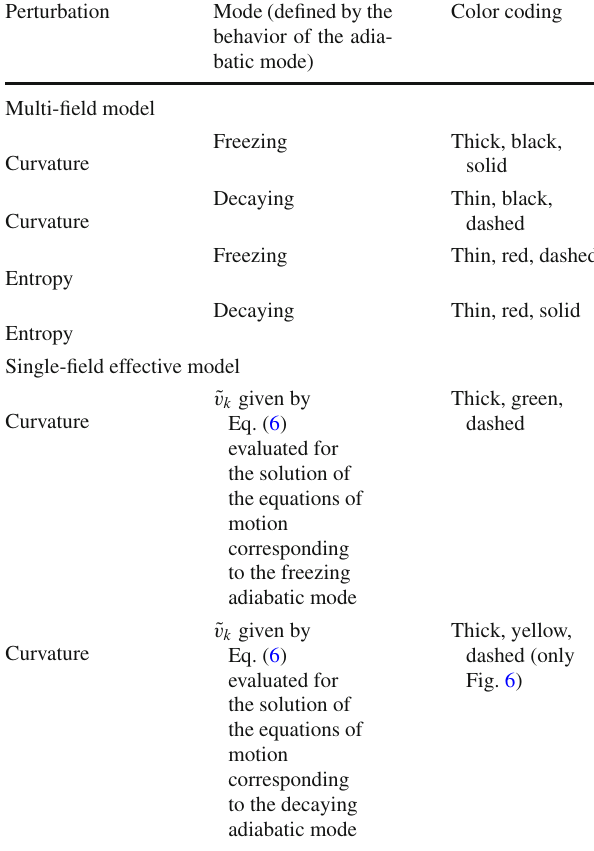
Table 1 Color coding of the perturbations in Figs.